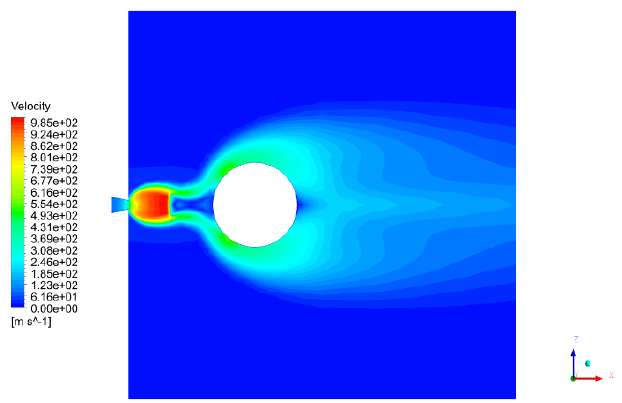
Figure 7. Velocity contour plot on the SB middle plane transversal to the obstacle. Table 3. Theoretical vs. CFD Mach disk position.